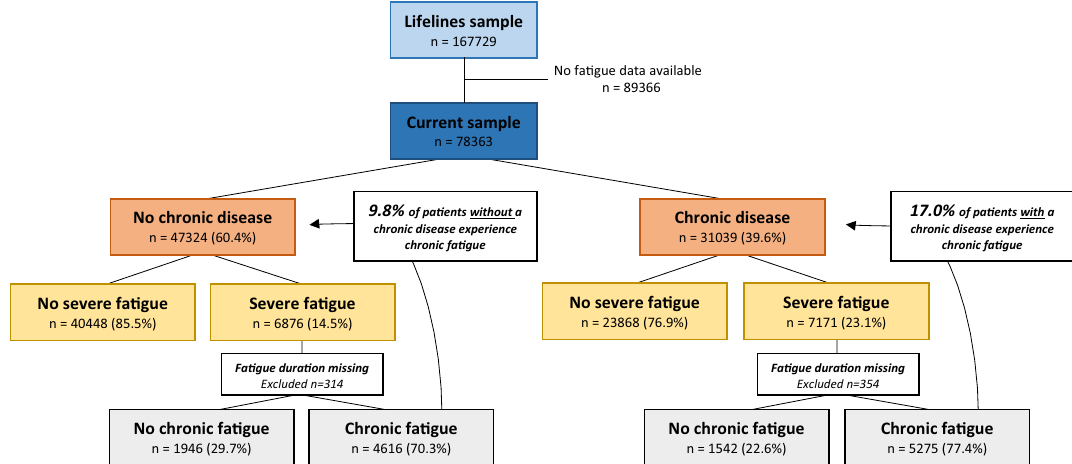
Figure 1. Prevalence of severe and chronic fatigue in participants with and without a chronic disease. Of note, participants with severe fatigue who did not report their fatigue duration were omitted from the analyses on chronic fatigue, hence the smaller sample size of chronic fatigue versus severe fatigue.